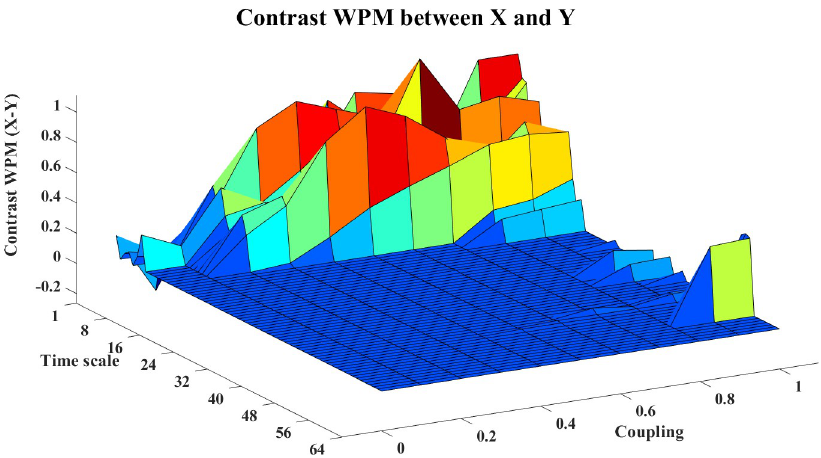
Fig 3. The contrast WPM information transfer values for the cosine map. This figure shows the 3D surface of the contrast WPM O WPM , X ! Y ( s i , e ) = WPM C , X ! Y ( s i , e ) − WPM C , Y ! X ( s i , e )(i = 1,2, ... 64,e = 0,0.1,0.2, ... ,1) for the cosine map. The surface represents the values of the corrected information transfer against time scale s e. The non-negative surface implies the directed information transfer from X- >